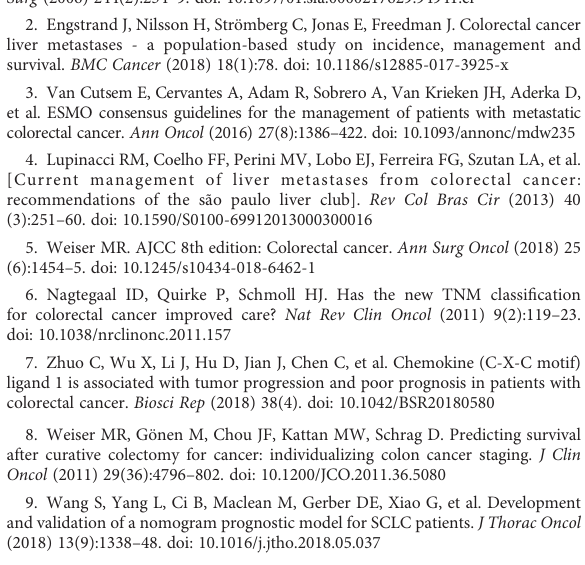
SUPPLEMENTARY FIGURE 1 Kaplan-Meier plot of CSS in stage M1a CRLM patients according to primary and metastatic resection. CSS, cancer speci fi c survival; CRLM, colorectal cancer with liver metastasis. SUPPLEMENTARY FIGURE 2 Construction ofthe new CRLMnomogram with the addition ofCEA.CRLM, colorectal cancer with liver metastasis; CEA, carcinoembryonic antigen. SUPPLEMENTARY FIGURE 3 Validation of the new CRLM nomogram. (A, B) ROC curve for discrimination in the training and validation cohorts. (C, D) Calibration plots for the actual (observed) and predicted probabilities of the new CRLM nomograms in the training and validation cohorts. SUPPLEMENTARY FIGURE 4 DecisioncurveanalysisofnewCRLMnomogramwiththeadditionofCEAin the training and validation cohorts. Horizontal lines indicates that no cases will experience the event; Gray lines indicates that all cases will experience the event; Red and blue lines represent the net bene fi ts across threshold probabilities according to the CRLM nomogram and TNM classi fi cation, respectively. CRLM, colorectal cancer with liver metastasis; TNM, tumor, node, and metastasis; CEA, carcinoembryonic antigen. SUPPLEMENTARY FIGURE 5 External validation of the nomogram. (A) ROC curve for discrimination in the FUSCC cohorts. (B) Calibration plots for the actual (observed) and predicted probabilities of the nomogram in the FUSCC cohorts. (C) Decision curve analysis of CRLM nomogram in the FUSCC cohorts. ROC, receiver operating characteristic curve; FUSCC, Shanghai Cancer Center, Fudan University. SUPPLEMENTARY TABLE 1 Characteristics of M1a CRLM patients. SUPPLEMENTARY TABLE 2 Characteristics of training set, internal and external validation